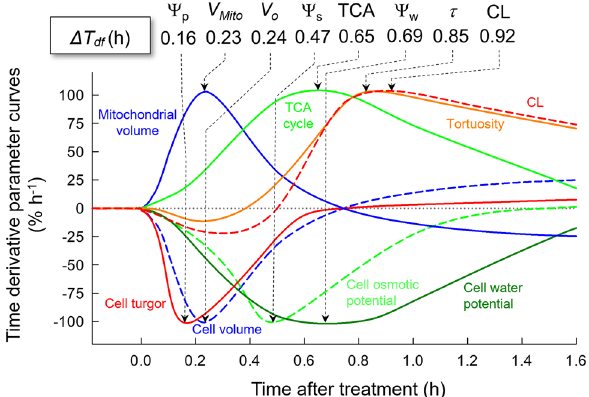
Figure 4. Kinetics of cellular parameters on turgor-driven cardiolipin (CL) biosynthesis and mitochondrial membrane dynamics in the stalk cells at salt stress. Time derivative parameter curves of cell turgor (Ψ p , red line), mitochondrial volume ( V Mito , blue line), cell volume ( V o , blue dashed line), cell osmotic potential (Ψ s , lime green dashed line), cumulative signal intensity of tricarboxylic acid (TCA) cycle metabolites (lime green line), cell water potential (Ψ w , green line), crista tortuosity ( τ , orange line), and CL (red dashed line) (also see Fig. S14A). All parameters were scaled by setting the maximum/minimum absolute value of the change to be + 100/−